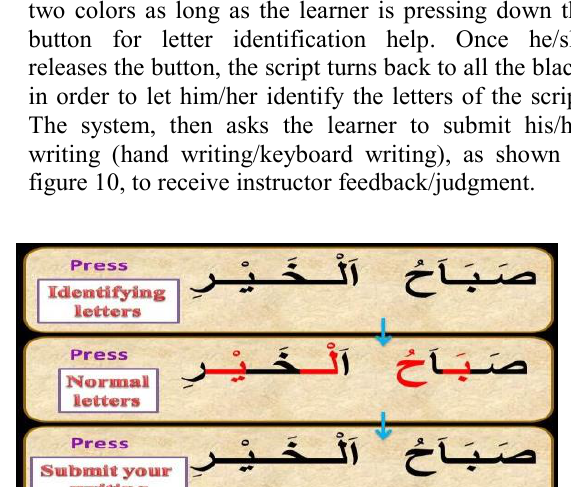
4. Exploratory experiment on colored new